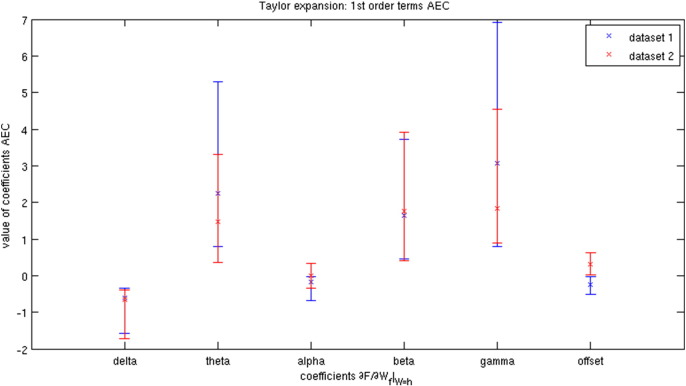
Estimated parameters (Taylor coefficients) for analysis level 1 using model b, linear approximation based on all MEG frequency bands using the PLI as functional connectivity metric for MEG. Note that the confidence intervals of the estimated Taylor coefficients for the two datasets almost completely overlap.